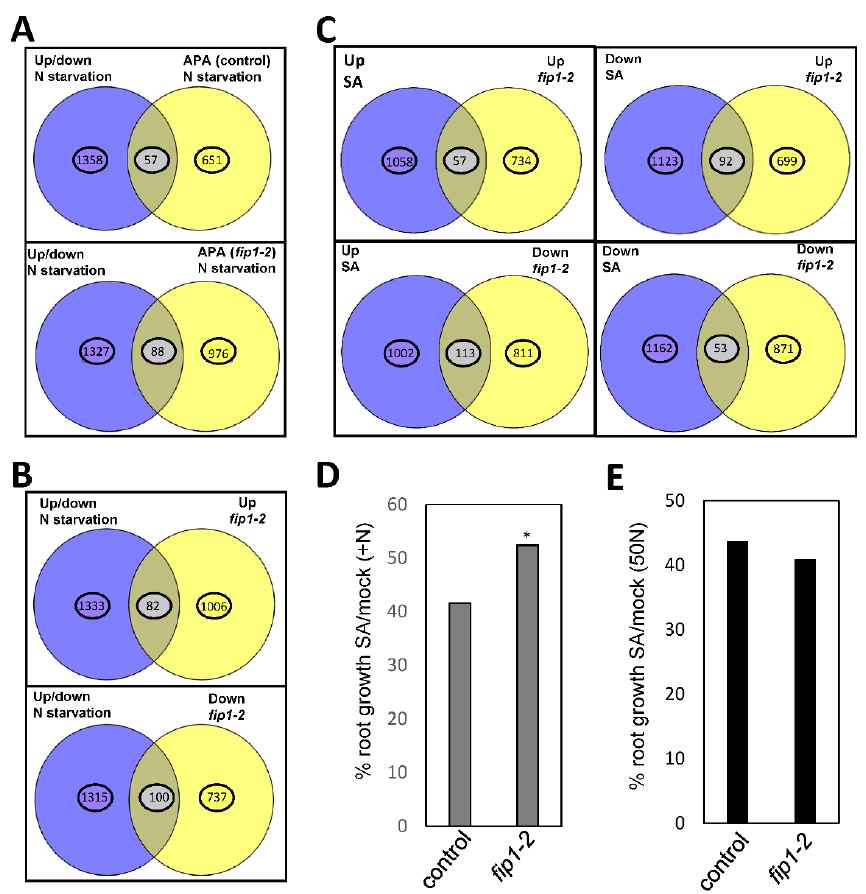
Figure 3. Transcript overlapping between alternative polyadenylation and N starvation responses and salicylic acid response. ( A ) Venny’s diagrams of common genes between of those up- and down-regulated (Up / down) by nitrogen starvation and transcripts showing APA in control or fip1-2 ( B ) Venny´s diagrams of common genes between genes up- and down-regulated by nitrogen starvation and genes up-regulated (Up) or down-regulated (Down) in fip1-2 . ( C ) Venny´s diagrams of common genes between genes up-regulated (Up) or down-regulated (Down) by salicylic acid treatment and genes up-regulated (Up) or down-regulated (Down) in fip1-2 . The full list of overlapping genes can be found in Table S2. ( D , E ) Percentage of main root growth of seedlings grown for 5 days in MS1/2 medium with high N (+N) (D) or low N (50N) (E) and then 5 days to a similar medium containing 0 or 50 µM of SA. *, p < 0.05 by t -Test compared to control.